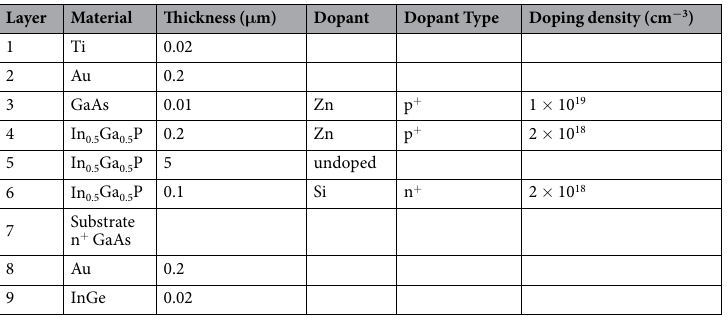
Table 1. Layer details of the In 0.5 Ga 0.5 P photodiode.